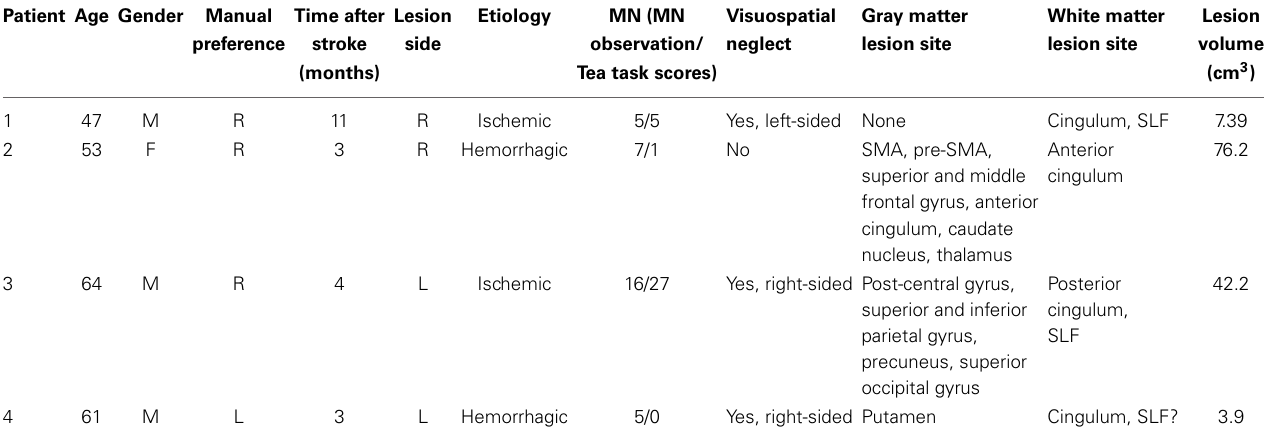
Table 1 | Demographics and clinical characteristics of Motor Neglect patients. Patient Age Gender Manual Time after